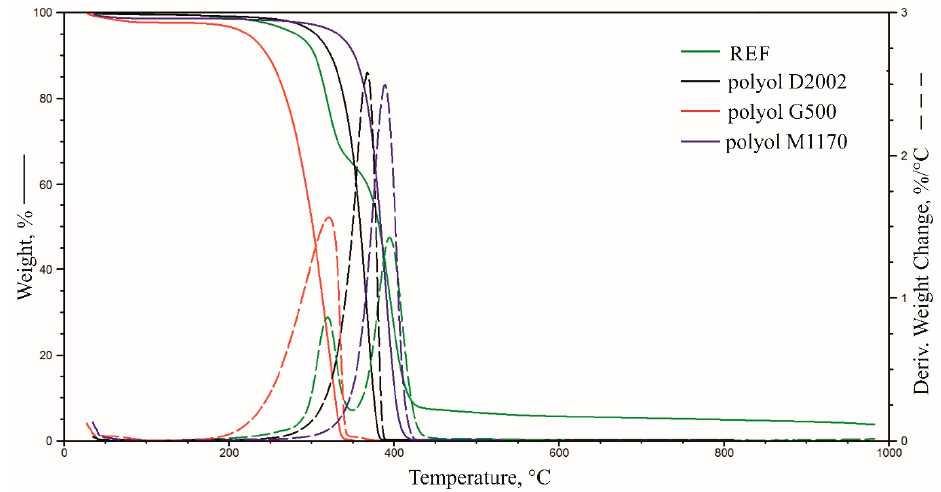
Figure 7. Summary of weight change and derivative weight change curves for the reference material and polyols.